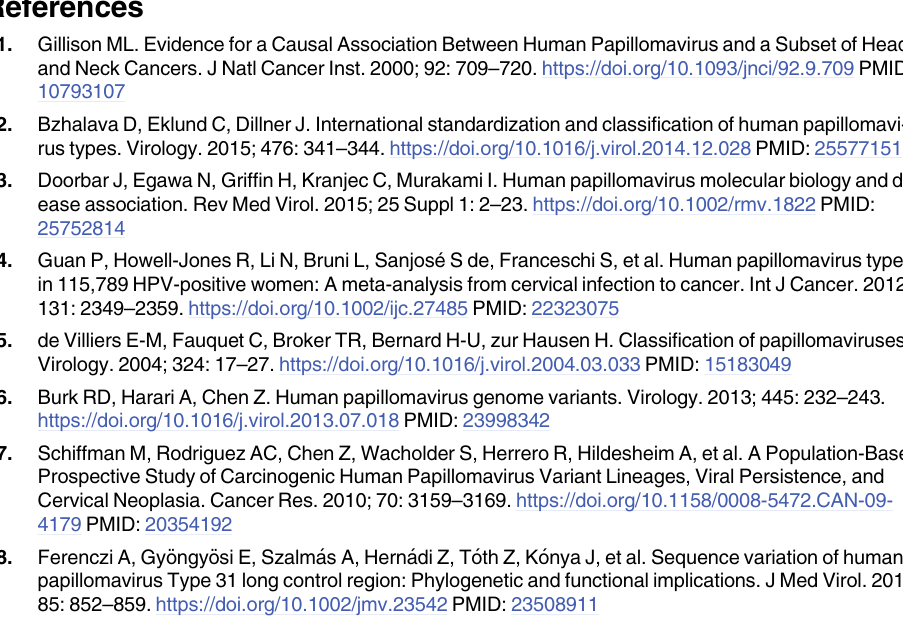
S1 Table. Raw data to calculate specific activity. S2 Table. Accession numbers of sequences used in primer design and comparative phylo- genetic